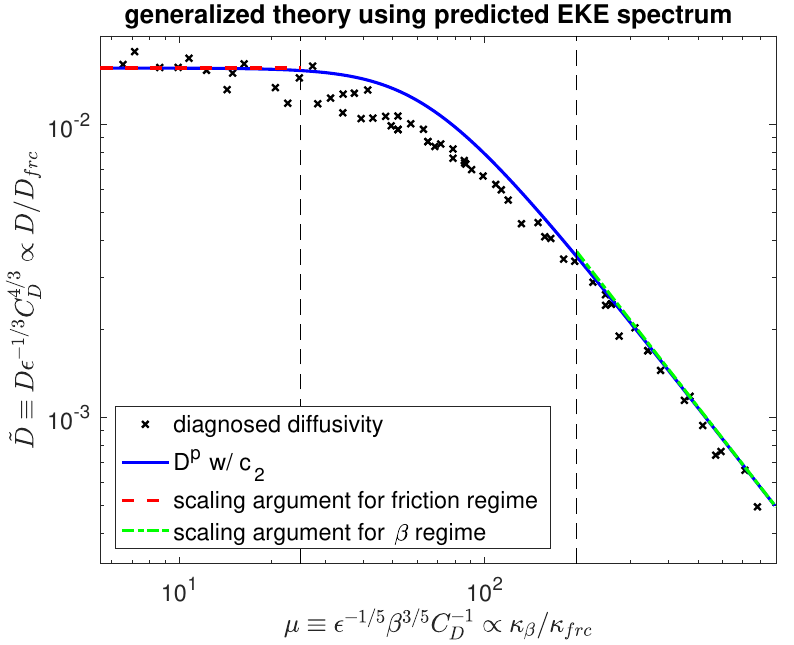
Figure 6. As Figure 5 but showing the closed generalized theory using the Kolmogorov spectrum to predict the eddy kinetic energy (EKE) spectrum. The scaling arguments for the friction and β regimes are also plotted in colored dashed